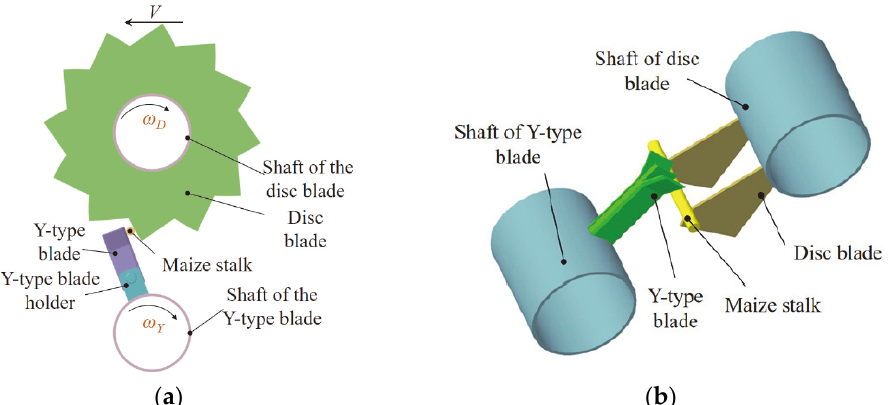
Figure 3. The model of FEA [54]. ( a ) The chopping device; ( b ) simplified structure of the model.